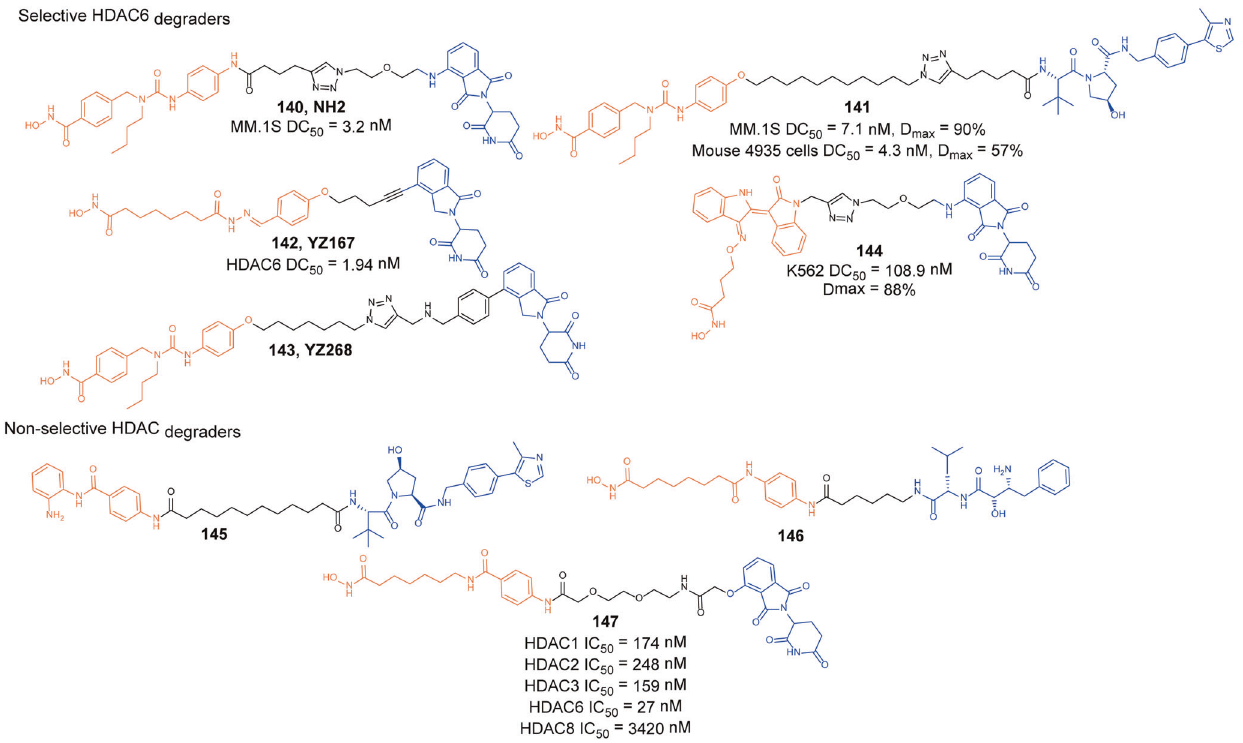
Fig. 33 The representative PROTACs targeting